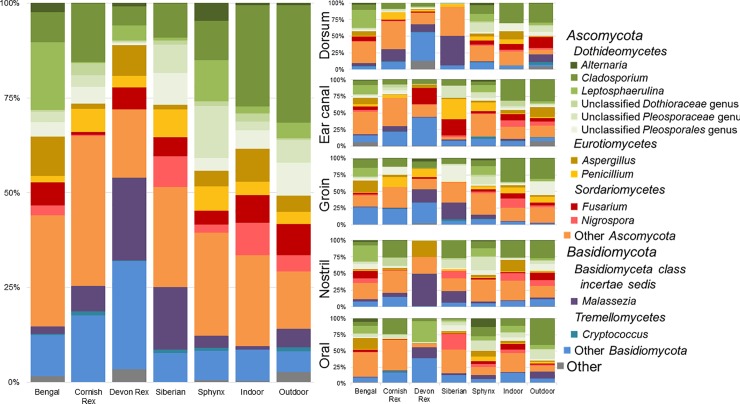
Average relative abundance of fungal taxa.The average relative abundance of fungal taxa across the different cat breeds and outdoor cats including all body sites and separated by body site.